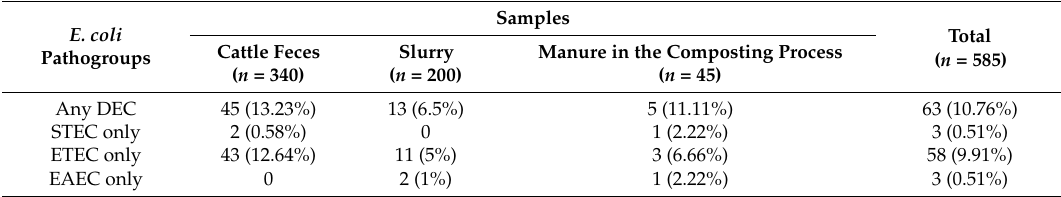
Table 4. Prevalence of diarrheagenic Escherichia coli (DEC) in organic waste products from cattle